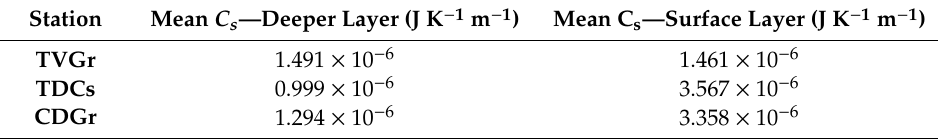
Table 6. Apparent Thermal Capacity in the surface layer of soil and in the deep layer in the three non-urban